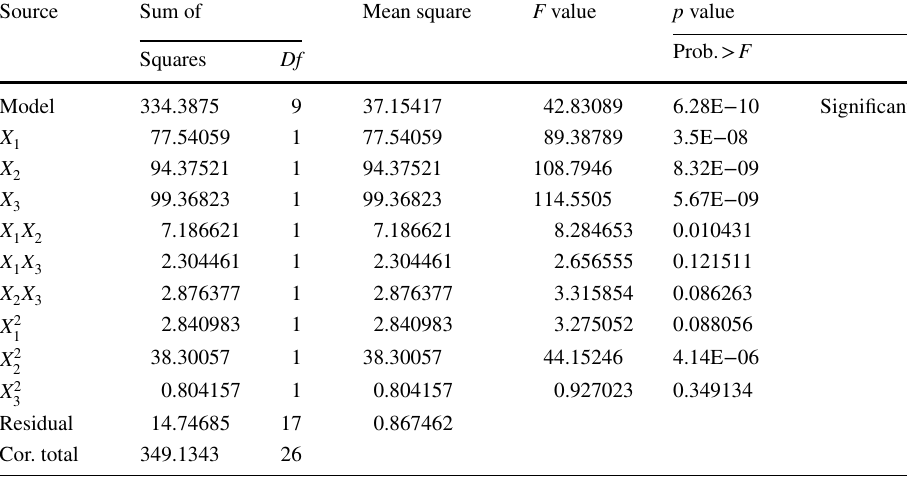
Table 5 ANOVA for response surface quadratic model for Pb(II) removal from an OSA